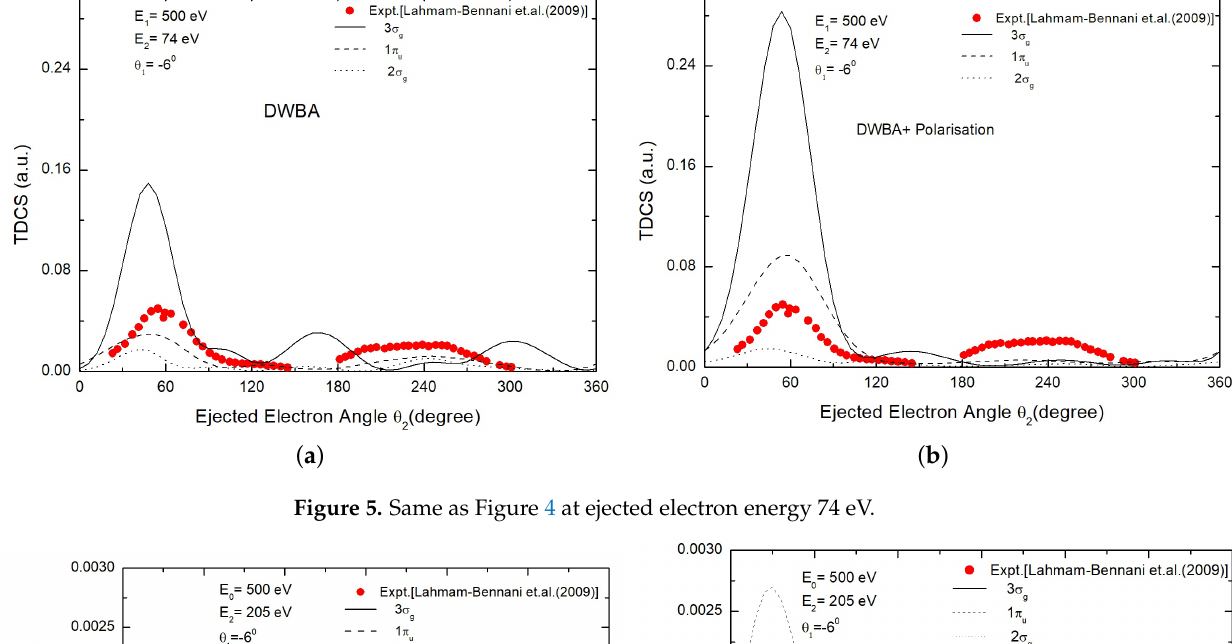
Figure 5. Same as Figure 4 at ejected electron energy 74 eV.